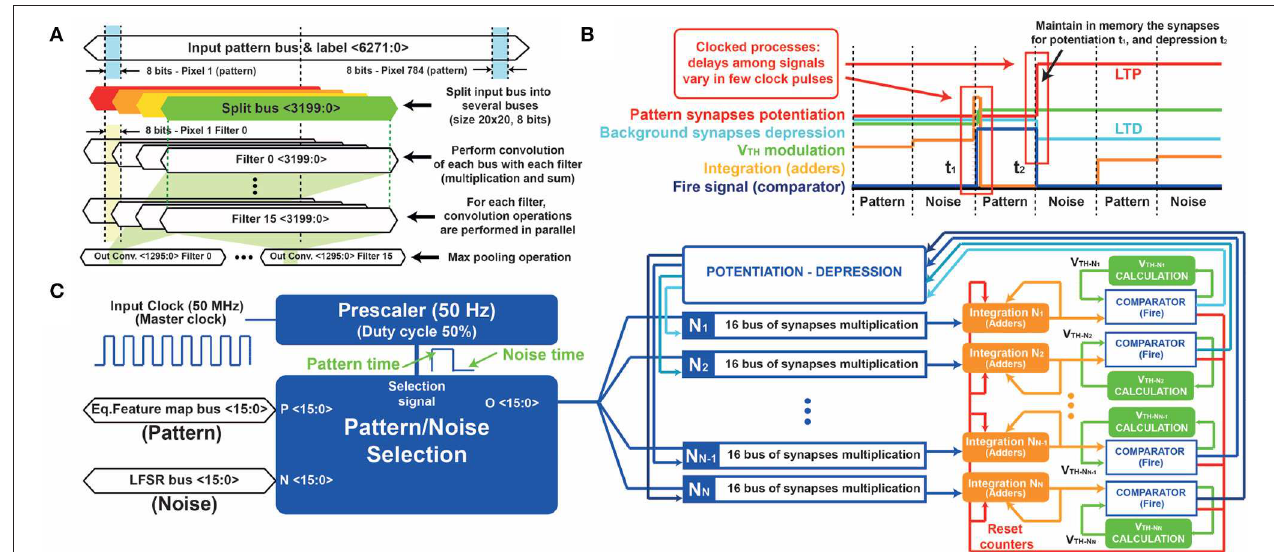
FIGURE 8 | (A) Detailed representation of the digital convolution operation. Input patterns are codified in buses of 6,272 bits (grayscale images of 28 × 28 pixels converted into 8 bits-integer binary data). Note that the input pattern is split into several subsets of buses, all with the same size of the convolutional filters. The elements of the split buses are multiplied by the elements of the convolutional filters one by one. The results are then summed up and stored into additional registers (16 buses of 81 elements each one). (B) Signal evolution during the STDP operation. Each time the pattern appears at the input, the adders increase their values, till the integration reaches the threshold. Then, the digital comparator maintains high its output for 10 ms, causing the potentiation/depression of the synapses at the falling edge. Since all the FPGA processes are synchronous, the delay between signals is much smaller ( µ s) than the time scale used during the STDP operation (tens of ms). (C) Detailed STDP-WTA scheme. Initially, the pattern/noise block alternates pattern (equalized feature maps) and noise (LFSR bus) at 50% rate of appearance, for a duration of 10 ms each. Each output neuron {1 ... N } performs the integration and the comparison respect to the internal threshold. If the comparator fires, the integrating adders are reset (inhibition) and the potentiation-depression block is activated to drive the excitatory synapses. In addition, the corresponding neuronal threshold is increased in order to improve the specialization